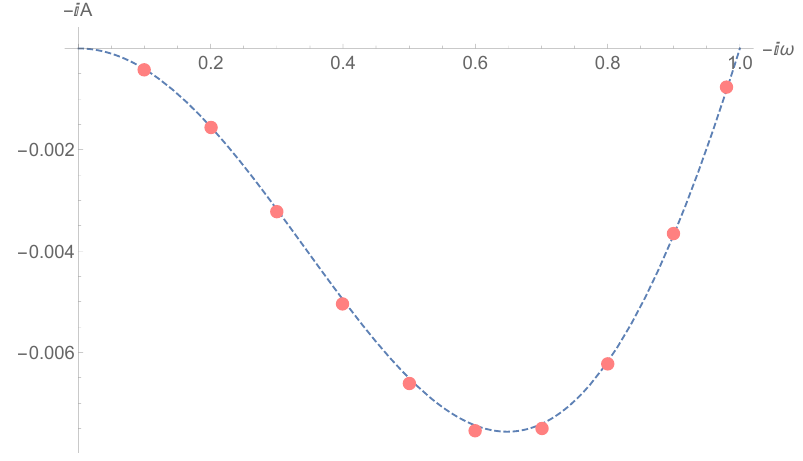
Figure 4 . Numerical results for genus one 2-point string amplitude (cid:0) i A (1) ! = ix , x > 0 (red dots) versus the matrix model result (cid:0) i A (1) dashed